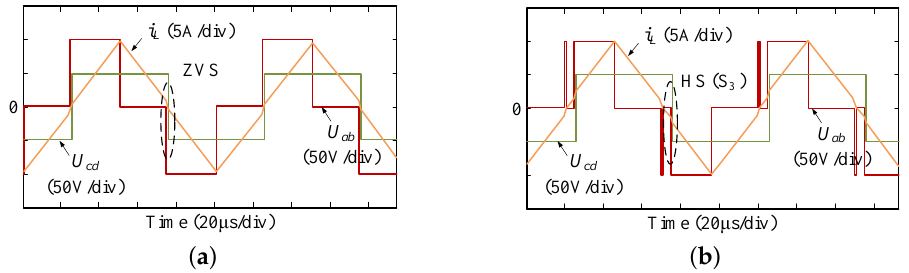
Figure 4. Simulation waveforms of DAB converter under UTPS scheme with U 1 = 100 V, U 2 = 50 V, and P = 344 W: ( a ) D 1 = 0.55, D 3 = 0, and M = 0; and ( b ) D 1 = 0.55, D 3 = 0, and M = 0.1.